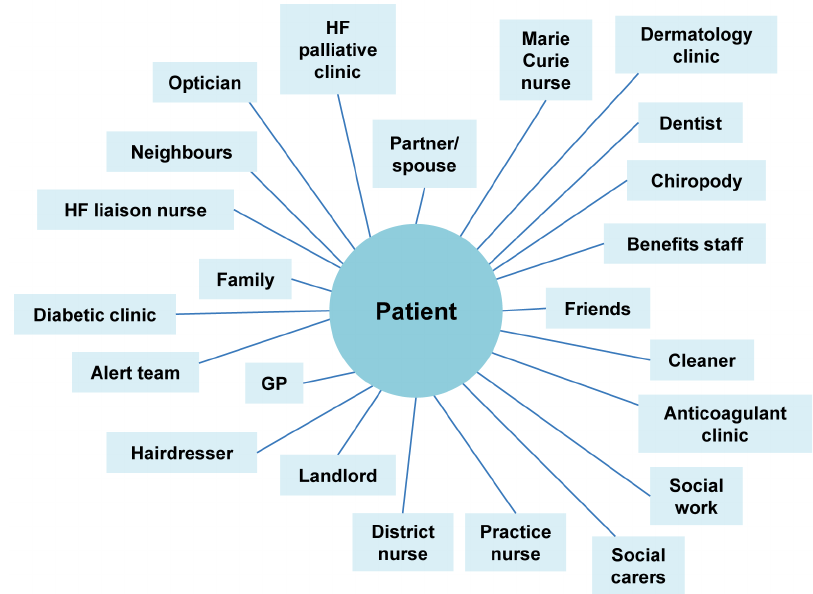
Figure 1. An illustration of the range of people HF patients describe dealing with.